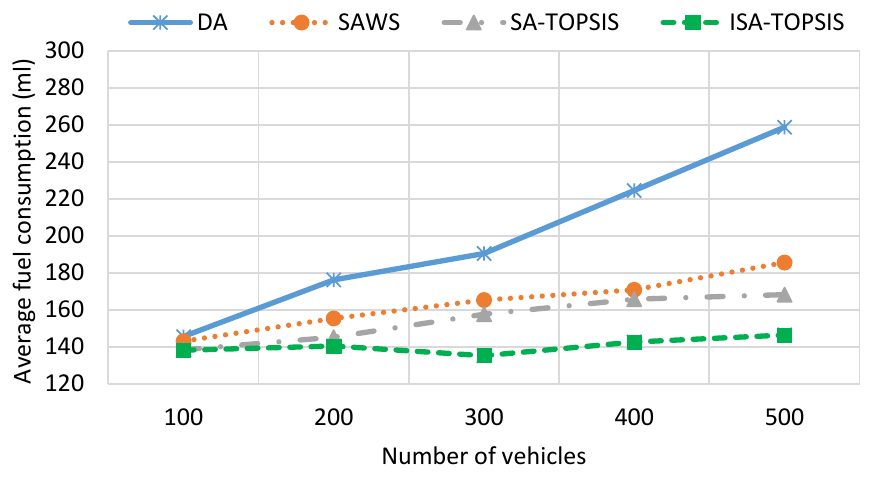
Figure 14. Average fuel consumption in the Birmingham